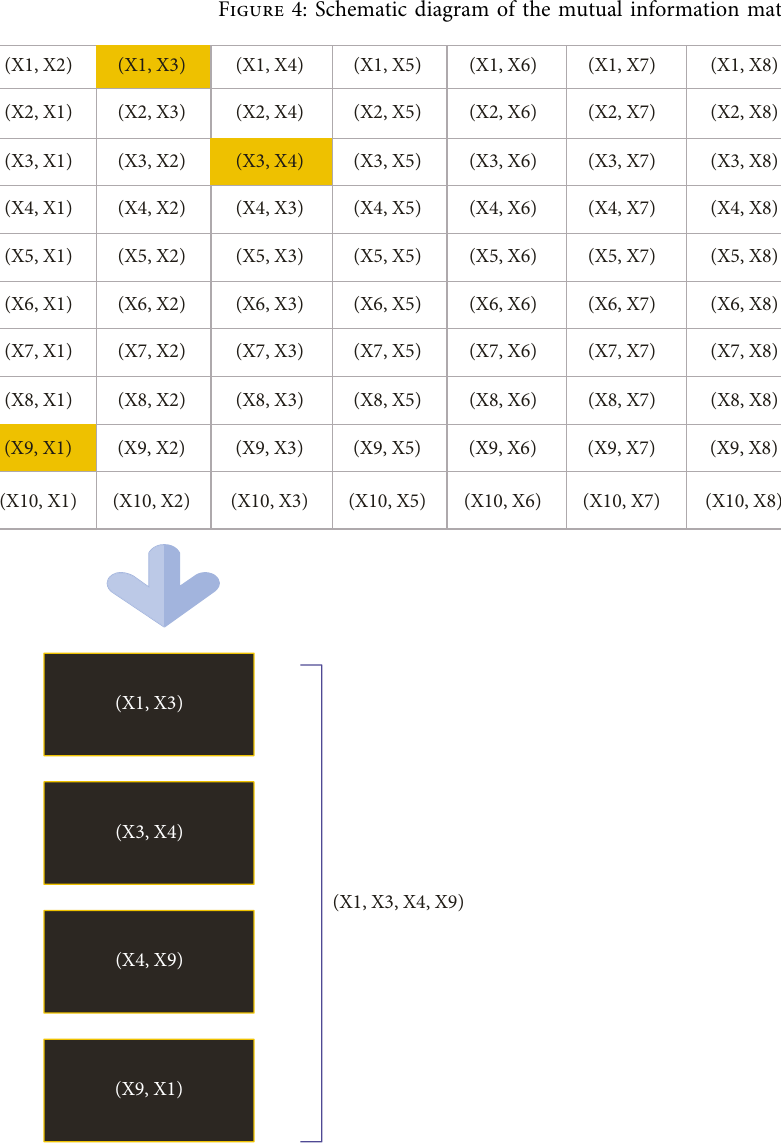
Figure 5: Schematic diagram of mutual information matrix